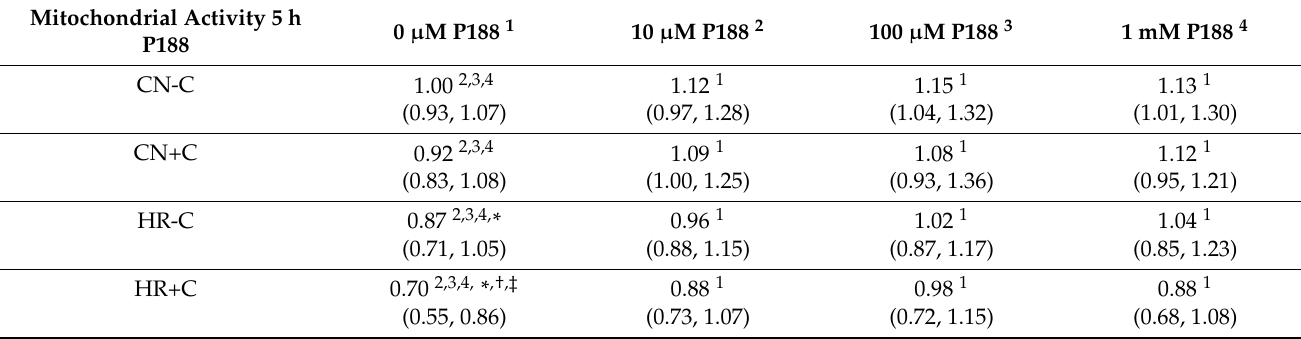
Table A3. Metabolic activity after 5 h injury and treatment with 0 µ M, 10 µ M, 100 µ M, and 1 mM of P188. Data from Figure 6 visualized as table (median, 25th, 75th percentile); p < 0.05; n = 10–19 experiments/group. Significances between different concentrations of P188 are displayed as superscripted numbers, significances between 0 µ M P188 CN-C, CN+C, HR-C, and HR+C are represented by symbols (* vs. CN-C 0 µ M P188, † vs. CN+C 0 µ M P188, ‡ vs. HR-C 0 µ M P188). Abbreviations: C, compression; CN, control/normoxia;